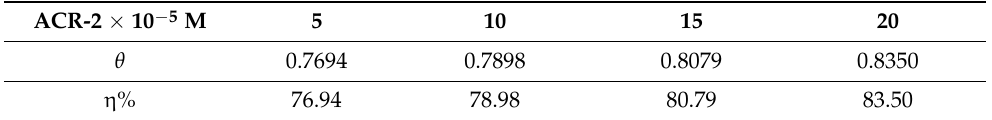
Table 2. Different measurements of inhibition for the corrosive effects of 1.0 M HNO 3 on copper with different concentrations both with and without ACR-2 at 25 ◦ C.